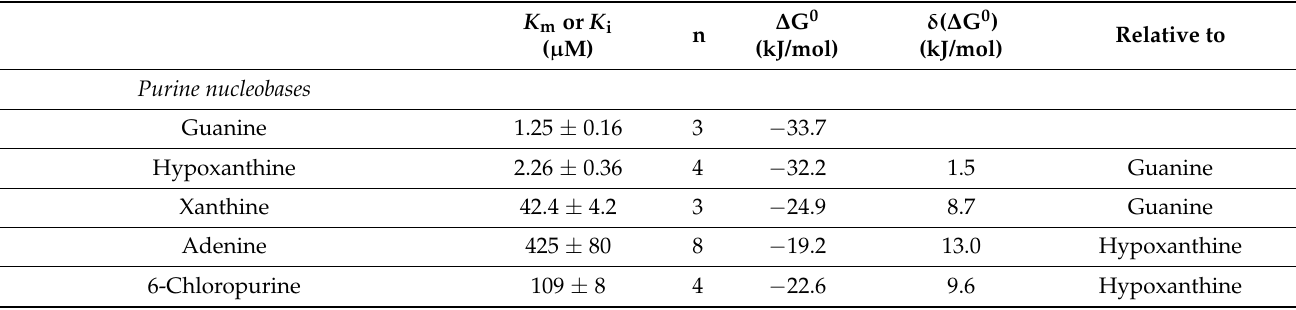
Figure 4. ( A ) Uptake of 0.05 µ M [ 3 H]-guanine over 30 s. Main graph: Michaelis-Menten saturation curve. Inset: shows the dose-dependent inhibition curves of the same experiment, for guanine (Gua), xanthine (Xan) and a single saturation point for hypoxanthine (Hyp). ( B ) Uptake of 0.10 µ M [ 3 H]-hypoxanthine over 30 s. Main graph: Michaelis-Menten saturation curve. Inset: dose-dependent inhibition curves of the same experiment (ade = adenine). ( C ) Inhibition of 0.05 µ M [ 3 H]-guanine over 30 s by unlabelled purine nucleosides adenosine (Ado), guanosine (Guo) and inosine (Ino). ( D ) Uptake of 0.05 µ M [ 3 H]-guanine over 30 s inhibited by pyrimidine nucleosides or nucleobases. Each bar is the average and SEM of 3–5 independent experiments, each performed in triplicate. Statistical difference with the control (empty vector pHD1336) was determined by Student’s unpaired t -test. *, p < 0.05. Table 2. Tg244440 Michaelis-Menten constant ( K m , guanine), inhibition constants ( K i ) and Gibbs Free Energy of interaction ( ∆ G 0 ) for various purine analogues. The structure of each purine and purine analogue is shown in Supplemental Table S3.